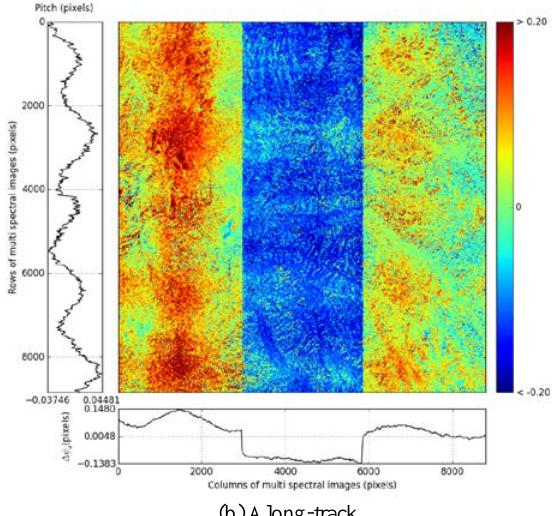
Figure 2 The band-to-band misregistration of Faizabad dataset with third-order polynomials.